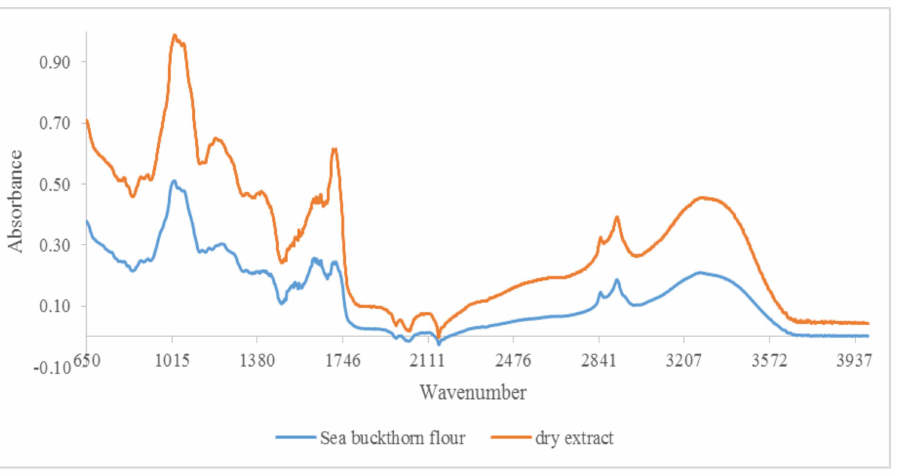
Figure 1. FTIR spectra for sea buckthorn flour and its dry extract in the region between 650 and 4000 cm − 1